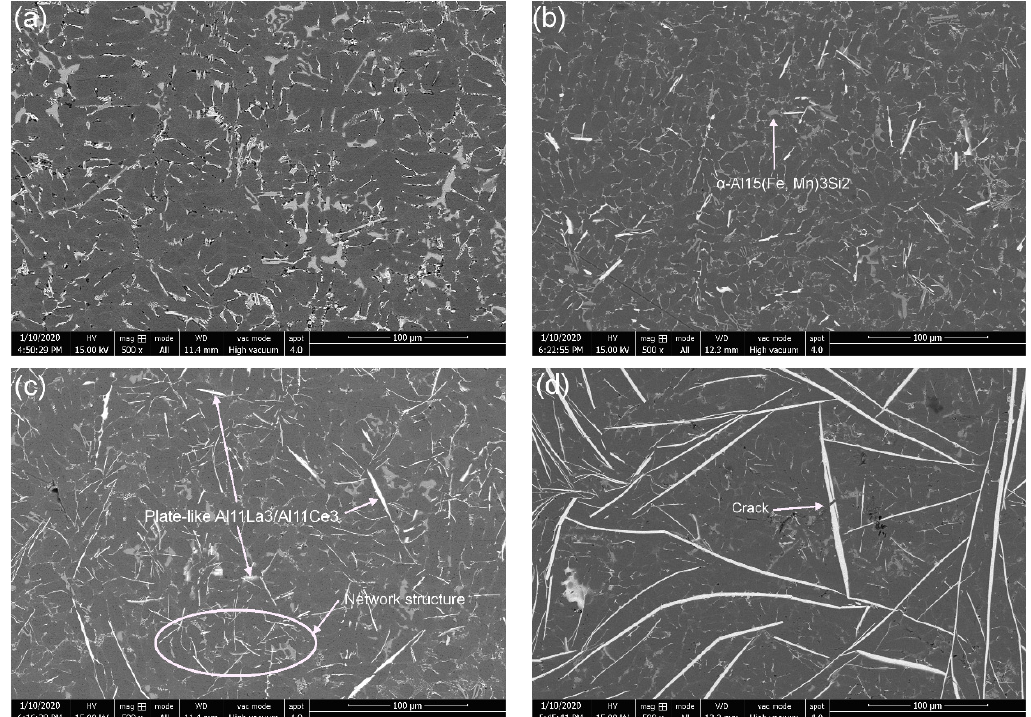
Figure 6. SEM micrographs of the 4 alloy produced with ( a ) 0% (Ce + La), ( b ) 1% (Ce + La), ( c ) 2% (Ce + La) and, ( d ) 4% (Ce + La). The white plate-like particles are Al 11 (Ce, La) 3 , blocky gray particles are α -Al1 5 (Fe, Mn) 3 Si 2 , gray non blocky regions are Al-Si eutectic.